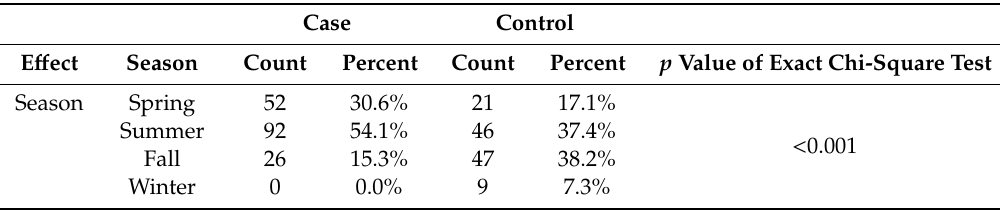
Figure 4. Acute cytauxzoonosis cases by month from May 2006 to Oct 2019. Case numbers represent the sum of total number of cases for each month from all years. These numbers represent raw acute cytauxzoonosis case counts. Table 2. Statistical analysis of season effect on acute cytauxzoonosis and control case incidence.